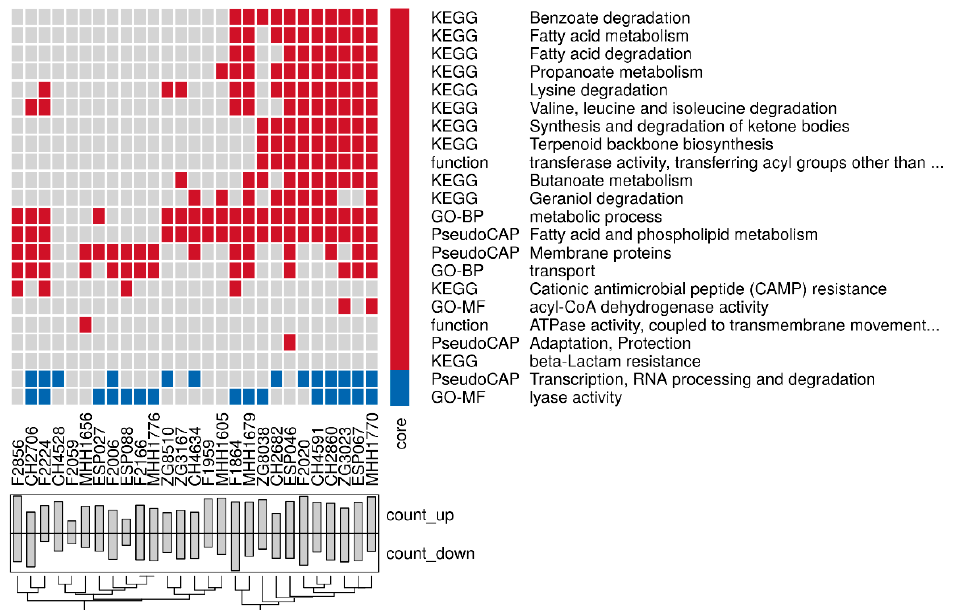
Figure 3. Enrichment of functional categories in the soft-core biofilm protein profile.All functional categories that were enriched (p-value < 0.05) in the group of proteins with a differential expression under biofilm as compared to planktonic growth conditions in at least 50% of the clinical isolates are listed. Function that were enriched in proteins that were up-regulated under biofilm condition in the individual isolates (x-axes) are colored in red, functions that were down-regulated are in blue. Bar plots indicate how many proteins were up and down-regulated in the individual strains. Functions were derived from KEGG-, PseudoCAP- or gene ontology (GO)-annotations. GO-MF = molecular function, GO-BP = biological process, GO-CC = cellular component.